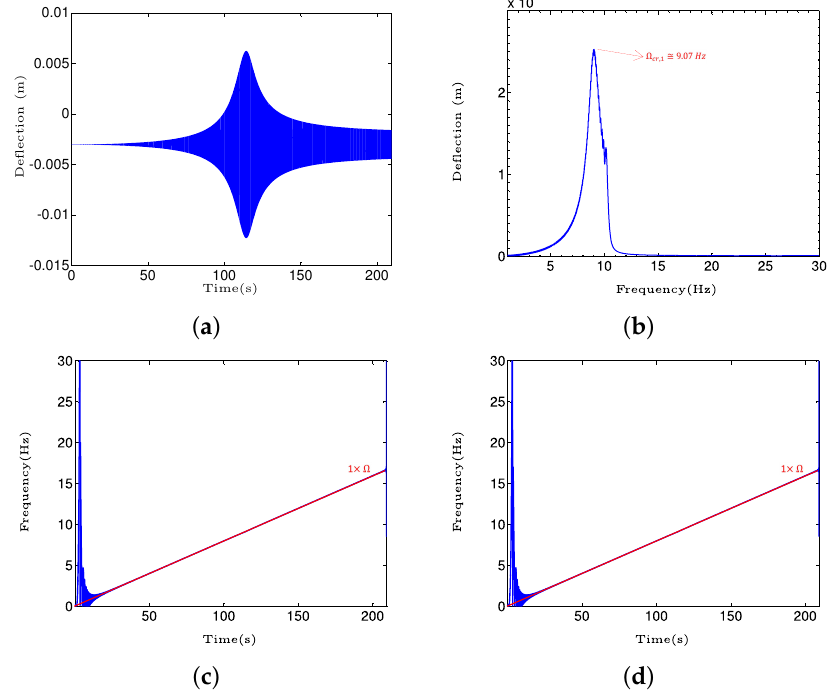
Figure 9. Intact Jeffcott rotor vertical transient response; ( a ) time response; ( b ) Fourier spectrum; time–frequency representation based on ( c ) EMD and ( d ) improved